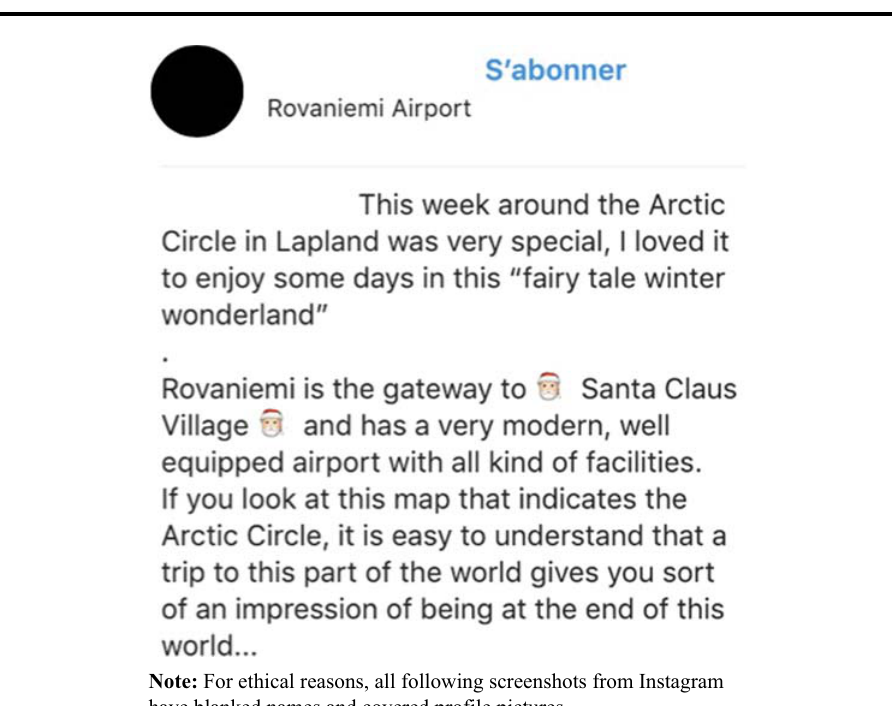
Figure 3 The Arctic Circle seen as the end of the